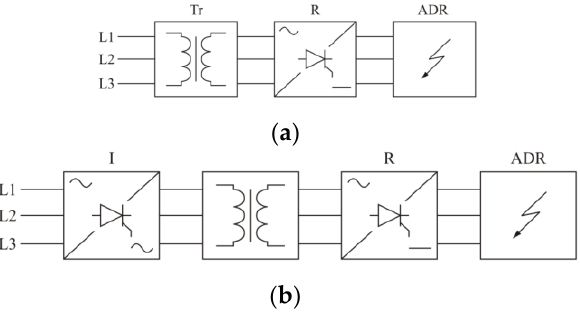
Figure 9. DC power systems of arc discharge reactor (ADR) with: ( a ) A controlled bridge (R) on the secondary side of the transformer (Tr); ( b ) with an AC controller (I) on the primary side of the transformer.